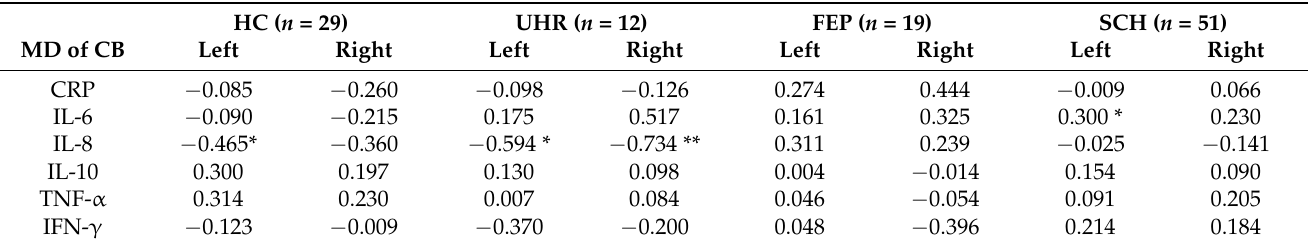
Table 3. Spearman rank correlation coefficients ( ρ ) for inflammatory markers and mean diffusivity (MD) of the left and right cingulum bundle (CB) in all analyzed